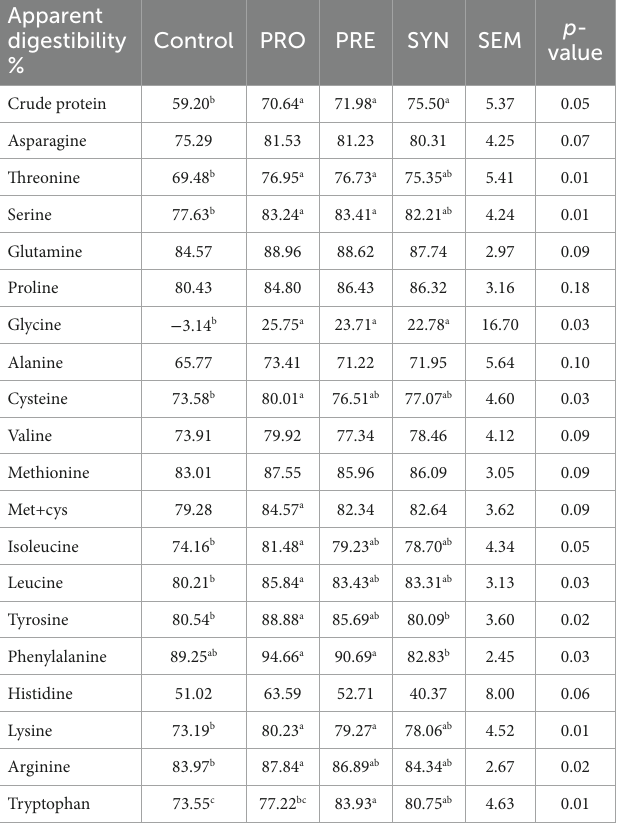
TABLE 8 Effects of dietary treatments on the jejunal villi morphometry of laying hens. Items